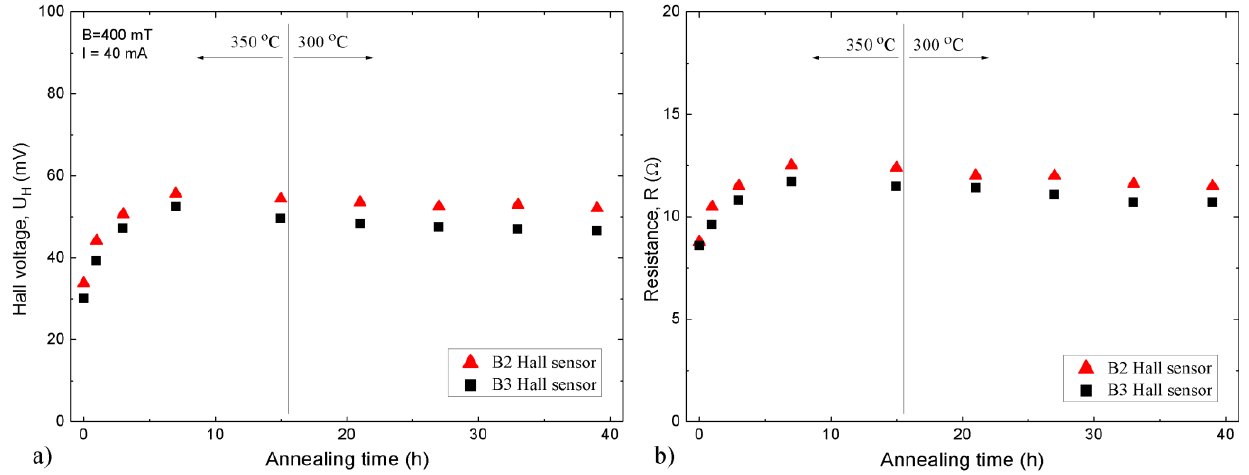
Figure 2. Effect of annealing on ET Hall sensors B2 and B3 performed at temperatures 350 °C and 300 °C; (a) change of Hall voltage, U resistance, R .